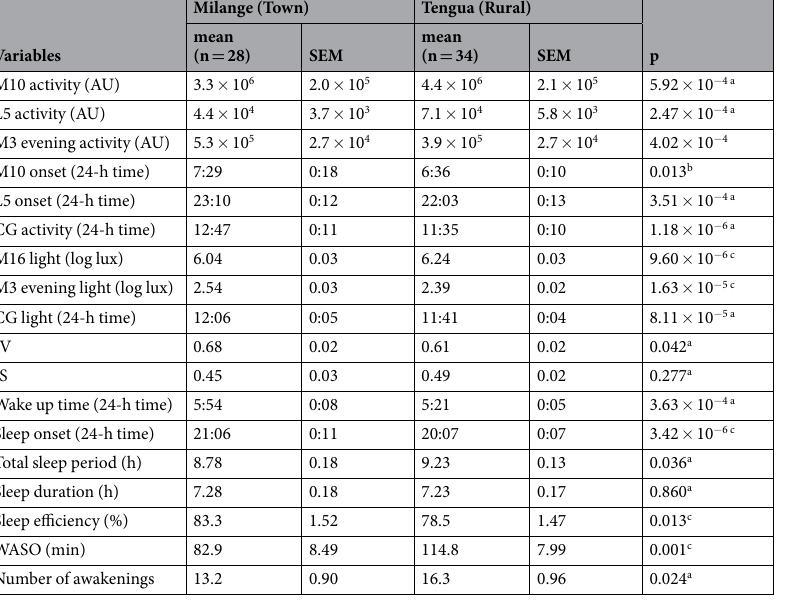
Table 1. Activity, light, and sleep variables calculated from actigraphy. M10 = total activity in most active 10-hour period, L5 = total activity in least active 5-hour period, M3 evening activity = total activity in 3 hours post sunset, M10 onset = onset time of M10 period, L5 onset = onset time of L5 period, CG activity = centre of gravity of activity, M16 light = total light exposure in brightest 16 hour period, M3 evening light = total light exposure in 3 hours post sunset, CG light = centre of gravity of light exposure, IV = intradaily variability, IS = interdaily stability, total sleep period = total time of actigraphy-scored sleep period, sleep duration = total time asleep in actigraphy-scored sleep period, sleep efficiency = total sleep duration/total sleep period, WASO = wake after sleep onset, number of awakenings = number of actigraphy-scored awakenings in the sleep period. M10 onset, L5 onset, CG activity, CG light, wake up time and sleep onset are indicated according to clock time. AU = arbitrary units. a Student’s t -test, b Welch Two Sample t -test, c Mann-Whitney U